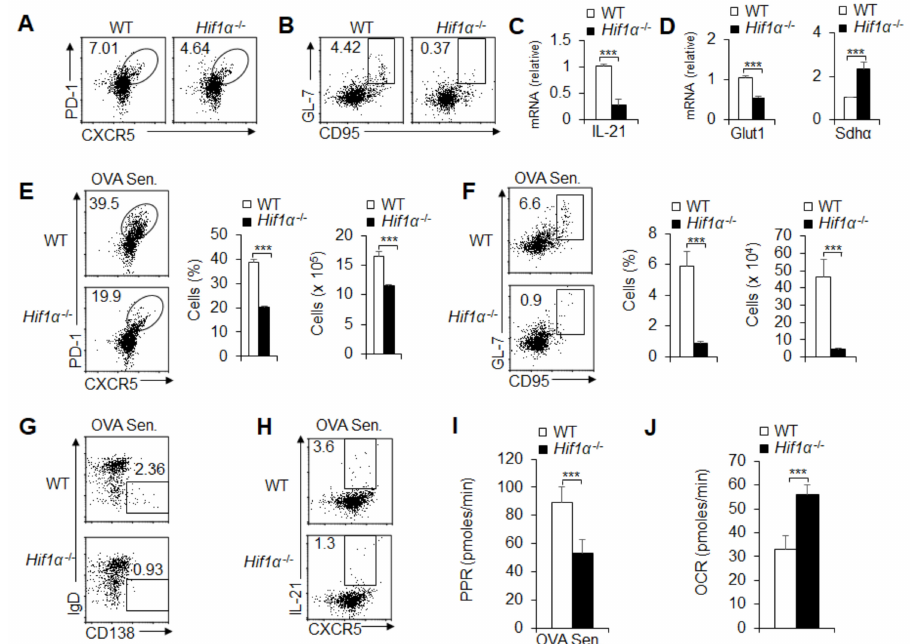
Figure 6. HIF1 α is responsible for glycolysis and OXPHOS in T FH cell di ff erentiation and GC responses. ( A , B ) Flow cytometry of T FH cells ( A ) and GC B cells ( B ) in spleens from WT and Hif1 α - / - mice. ( C ) Il21 mRNA expressions of T FH cells sorted from splenocytes in WT and Hif1 α - / - mice. ( D ) Glut1 and Sdh α mRNA expressions of T FH cells sorted from splenocytes in WT and Hif1 α - / - mice. ( E – J ) WT and Hif1 α - / - mice underwent intraperitoneal OVA immunization (OVA Sen.) with OVA plus LPS in alum at 8 days, and mouse spleens were isolated for analysis. ( E , F ) Flow cytometry of T FH cells and GC B cells in spleens from WT and Hif1 α - / - mice after immunization. The frequency and the number of T FH cells and GC B cells are shown in the right panel. ( G , H ) Flow cytometry of plasma cells and IL-21 + T FH cells in spleens from WT and Hif1 α - / - mice after immunization. ( I – J ) PPR ( I ) and OCR ( J ) were analyzed as the readout of glycolysis and OXPHOS in T FH cells sorted from splenocytes in WT and Hif1 α - / - mice after immunization, respectively. Data are representative of four individual experiments (n = 4–5 mice per group). *** p < 0.001, compared with the indicated